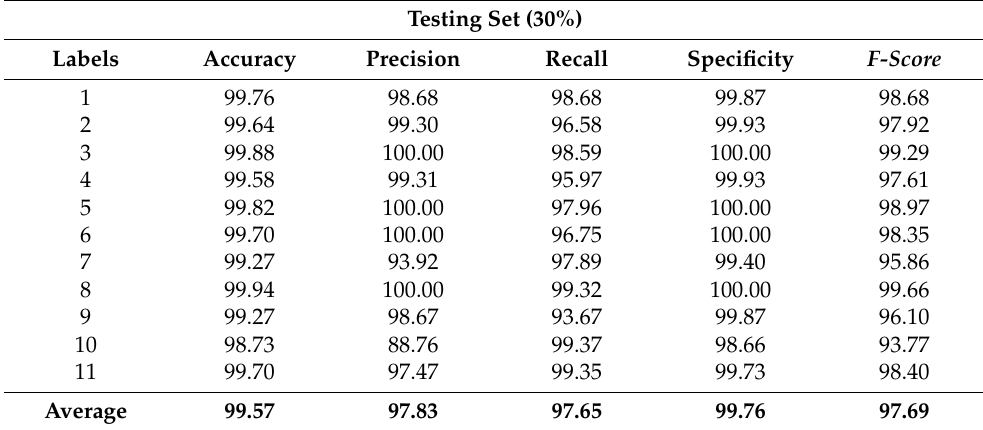
Table 4. Result analysis of PODCNN-LWID approach with distinct class labels with 30% of TS data.